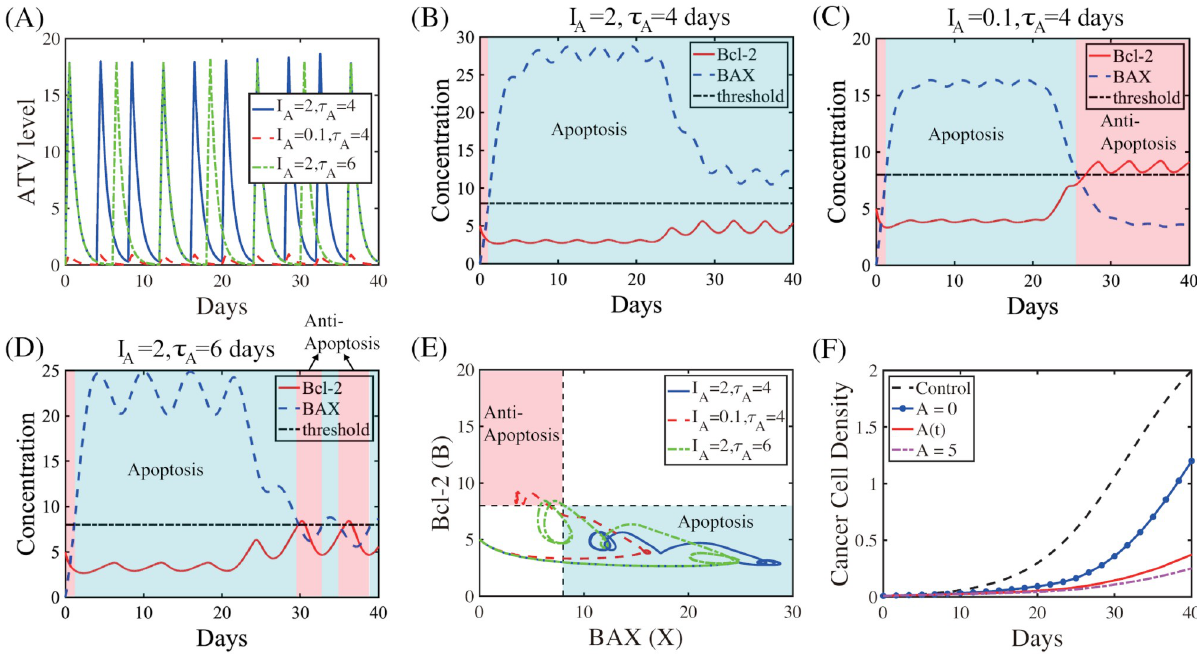
Fig 8. Anti-tumor efficacy and intracellular dynamics in response to ATV infusion. (A) Time courses of the ATV levels in response to fluctuating ATV infusion with various doses ( I A ) and periods ( τ A ; days): blue solid ( I A = 2, τ A = 4), red dashed ( I A = 0.1, τ A = 4), green dotted ( I A = 2, τ A = 6). (B,C, D) Time courses of the concentrations of Bcl-2 (red solid) and BAX (blue dashed) in response to fluctuating ATVs: I (C), I A = 2, τ A = 6 (D). Black dotted line = the threshold of Bcl-2 and BAX level. Apoptotic and anti-apoptotic areas are marked in light blue and pink boxes, respectively. (E) Dynamics of Bcl-2 and BAX corresponding to (B-D) in the X − B plane. (F) Time courses of the tumor density for control (black dashed; TZB − ATV − ), TZB treatment alone (blue circle; A = 0; TZB + ATV − ), periodic ATV infusion (red solid; TZB + ATV +/ � ) and combination treatment (pink dashed; A = 5; TZB + ATV +